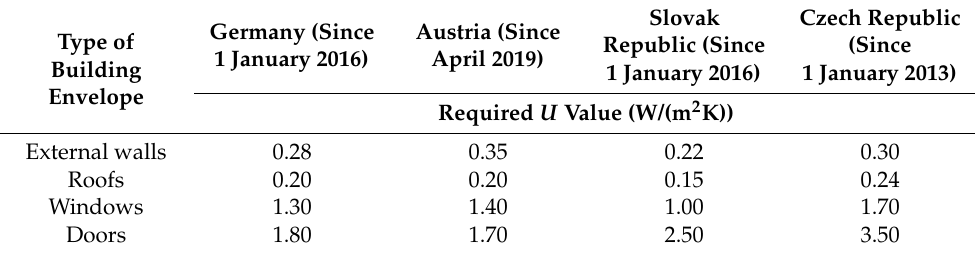
Table 2. Required values of the thermal transmittance coefficient of the selected building envelope in several countries